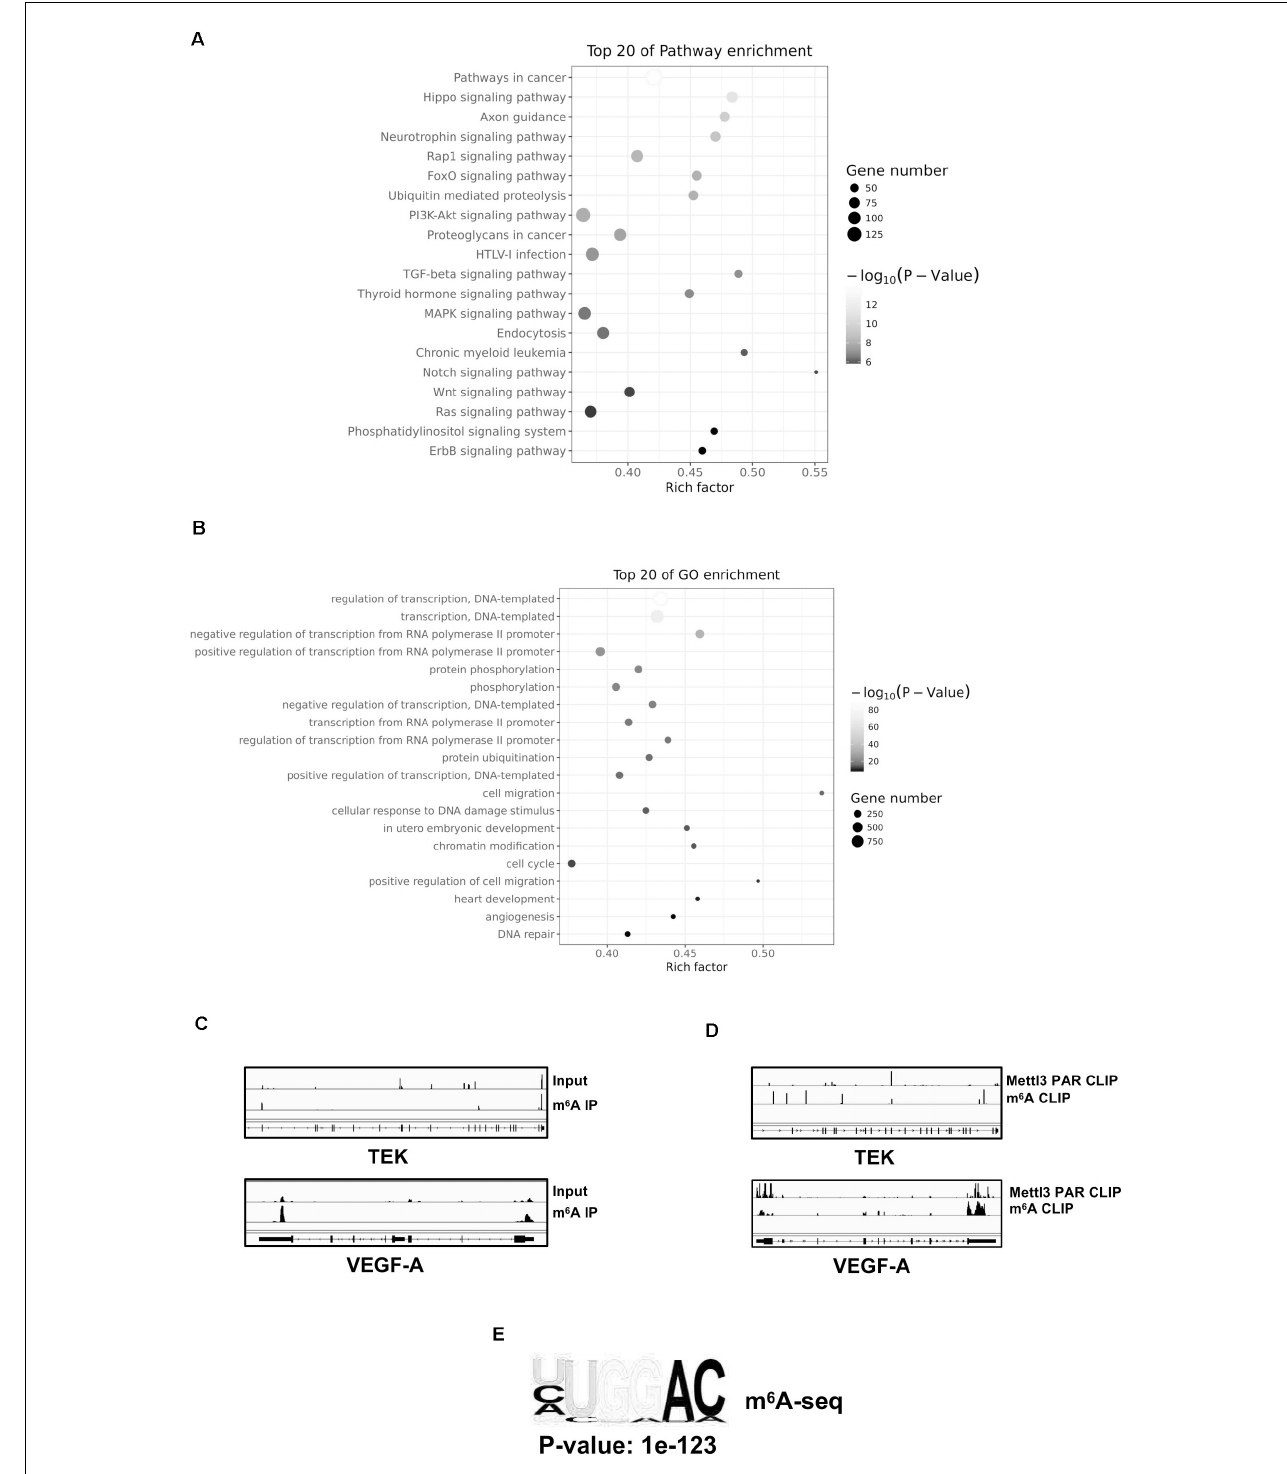
FIGURE 5 | Mettl3-mediated m 6 A modification of genes correlated with PI3K pathway and angiogenesis. (A) Top 20 of pathway enrichment related to regulation by Mettl3 was displayed by bubble chart. (B) The m 6 A-enriched genes were analyzed by Gene Ontology Biological Process exhibiting top 20 Gene Ontology (GO) enrichment process. (C) Integrative Genomics View (IGV) tracks showing the distributions of Mettl3 binding areas and m6A reads across TEK and VEGF-A mRNAs generated from meRIP-seq. (D) IGV tracks showing the distributions of Mettl3 binding areas and m 6 A reads across TEK and VEGF-A mRNAs generated from Mettl3 PAR CLIP-seq or m 6 A CLIP-seq. (E) The most common methylated consensus motif of “GGAC” catalyzed by Mettl3 was determined by HOMER (http://homer.ucsd.edu/homer/ngs/peakMotifs.html).